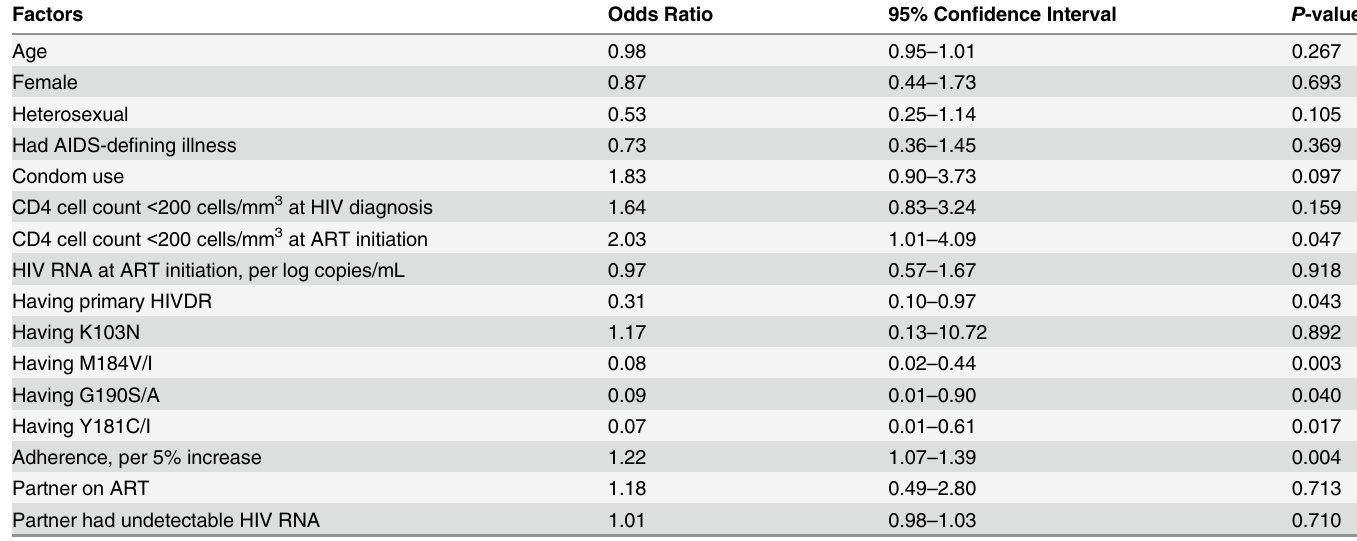
Table 3. Factors Associated with Undetectable HIV RNA at 6 Months after ART Initiation, by Univariate Logistic